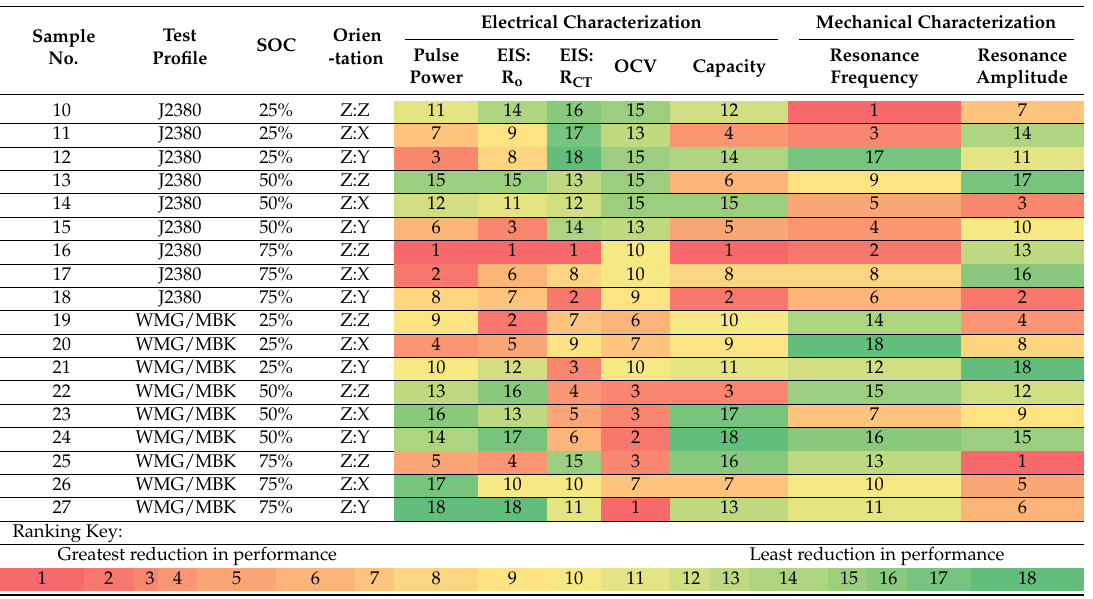
Table 14. Comparison of cell performance ranking by post-test